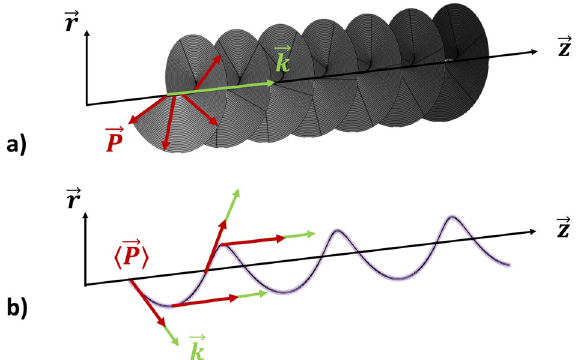
Figure 1. Pictorial view of ( a ) LOAM and ( b ) TOAM beam propagation.